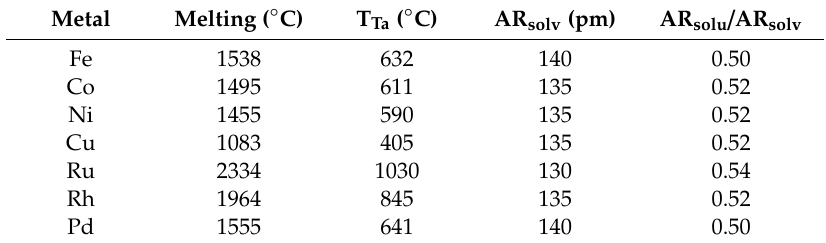
Table 2. Melting points, Tammann temperatures and interstitial C di ff usion data for seven metals frequently used as catalysts for carbon formation. Ratios of atomic radiuses (AR) of solute (C atoms) and solvent (metal catalysts) are between 0.50–0.54. As a rule, when the ratio is below 0.59, interstitial di ff usion operates [8]. That ratio condition is fulfilled by carbon atoms bulk di ff usion in all metals